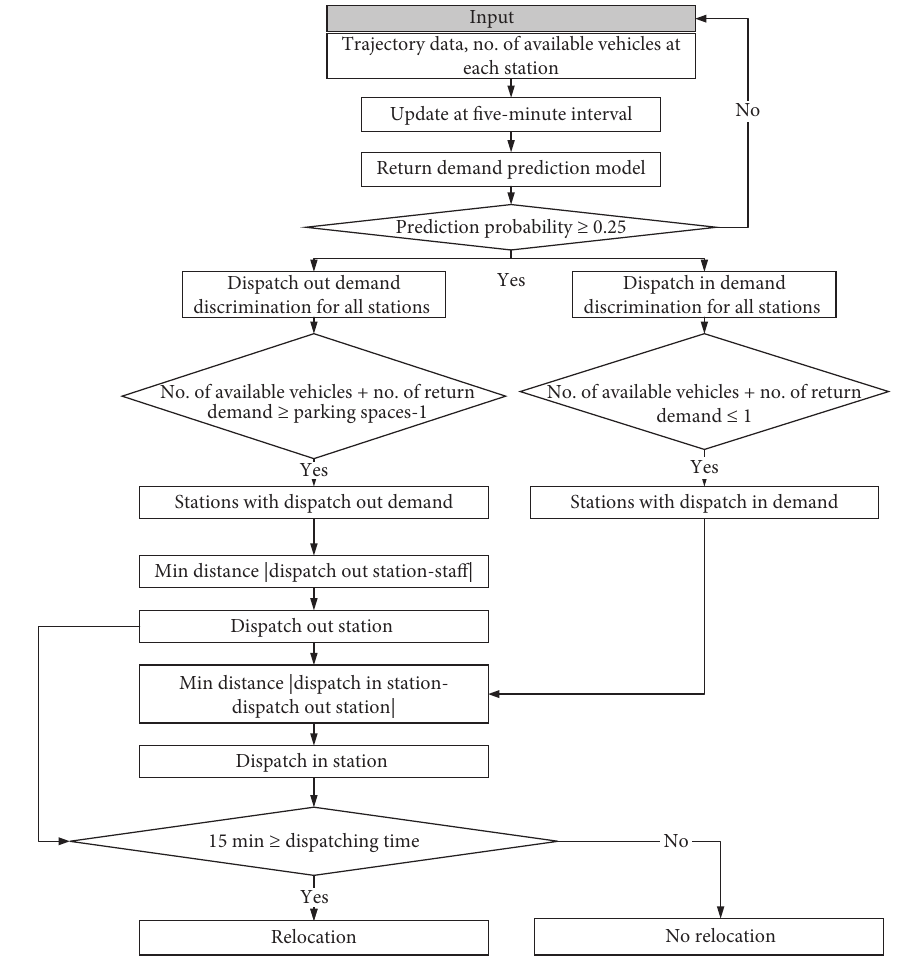
Figure 7: Relocation with